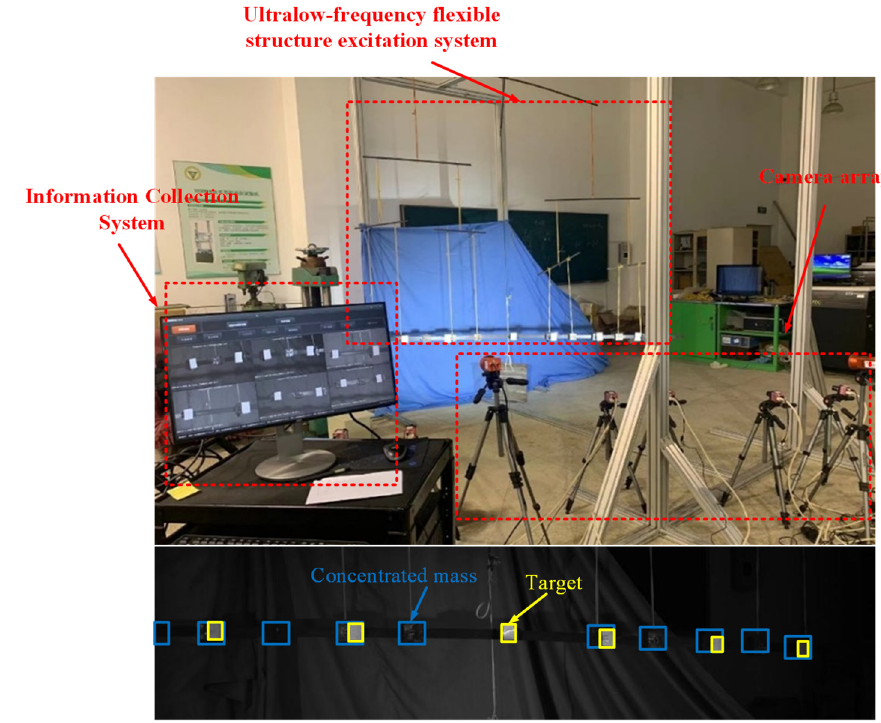
Figure 10. Test site map.